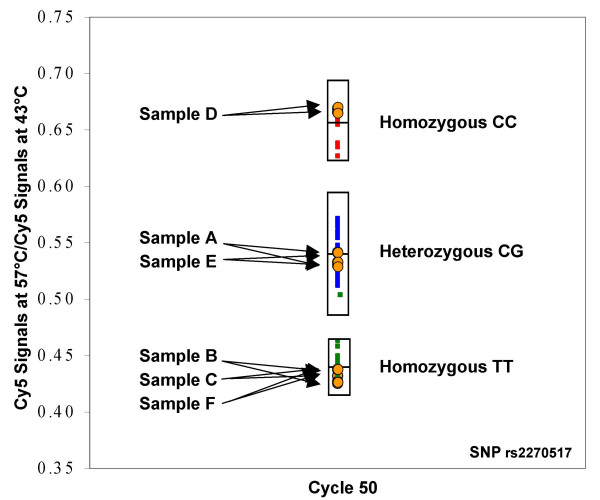
Two-Temperature LATE-PCR endpoint genotyping of the rs2270517 SNP in blinded DNA samples. Control replicate DNA samples corresponding to various known genotypes for the rs2270517 SNP were analyzed by Two-Temperature LATE-PCR using primer/probe pairs for the rs2270517 (C/T alleles) and a mismatch-tolerant probe specific for the C allele at high temperatures. Fluorescence signals were collected after LATE-PCR amplification at 57°C and 45°C and were used to calculate fluorescence ratios. In an initial experiment, replicate samples of each rs2270517 genotype (n = 26) were used to determine the distribution of fluorescence ratios corresponding to each genotype. Red dots indicate homozygous CC control samples, blue dots indicate the heterozygous CT control samples, and green dots indicate homozygous TT control samples. The boxes represent the boundary of three-tandard deviations on either side of the mean of replicate control samples signals for each genotype. Therefore, each box defines the range of fluorescence ratios statistically encompassing 99.7% of all possible samples of any given genotype in this assay. In two subsequent separate experiments, samples of known rs2270517 genotype that were blinded to the experimenter (coded samples A, B, C, D, E, and F in the figure) along with a set of control samples of known genotypes were processed to determine their fluorescence ratios in duplicate. These fluorescence ratios are shown in the figure as orange circles labelled with the sample designation; some of the circles from individual samples overlap in the figure. The data shows that the fluorescence ratios from each of the blinded samples fell within one of the defined ranges of normalized control fluorescence ratios. The same was observed for the set of control samples (shown as red, blue, or green dots according to genotype as specified above). There was 100% concordance in the genotype assignment when the blinded samples were decoded.